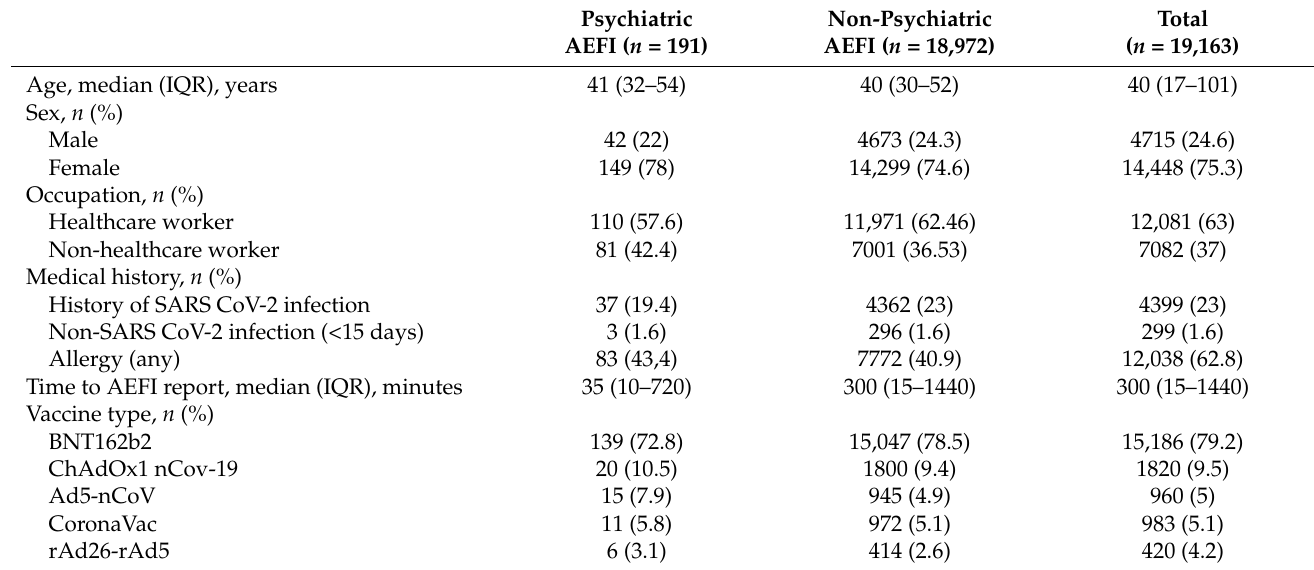
Table 1. Baseline characteristics according to the development of psychiatric